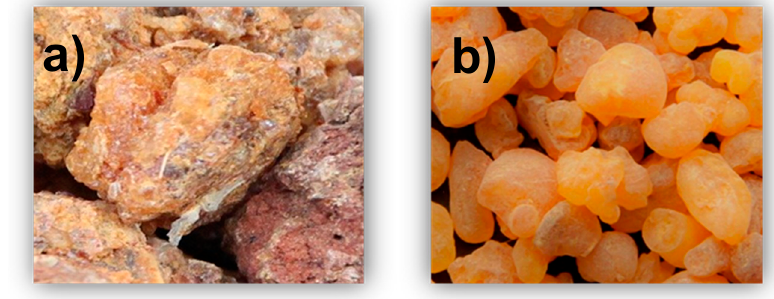
Figure 1. Myrrh ( a ) and frankincense ( b ).